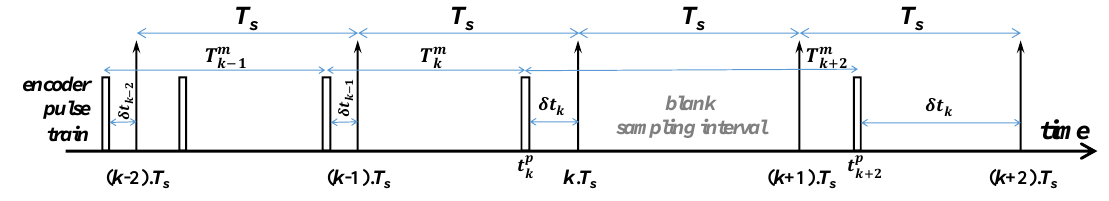
Figure 2. The timing diagram of encoder pulses widespread with a blank sampling interval.